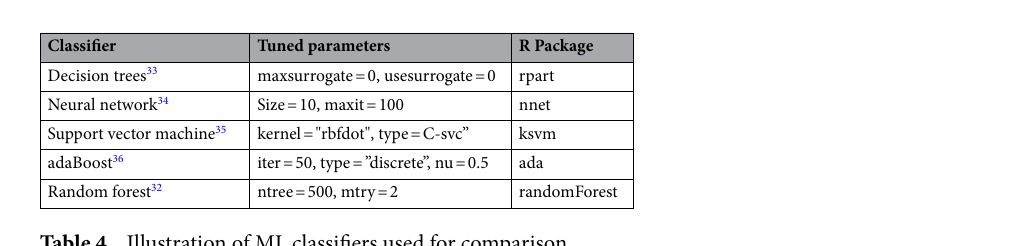
Figure 5. Decision tree classifier.